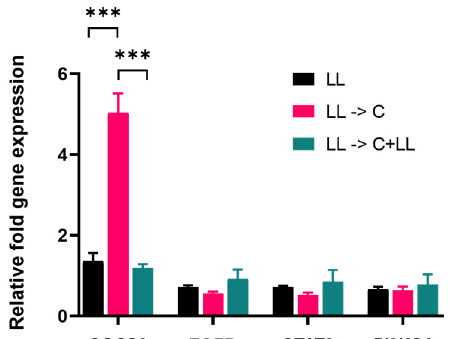
standard error of the mean. represent